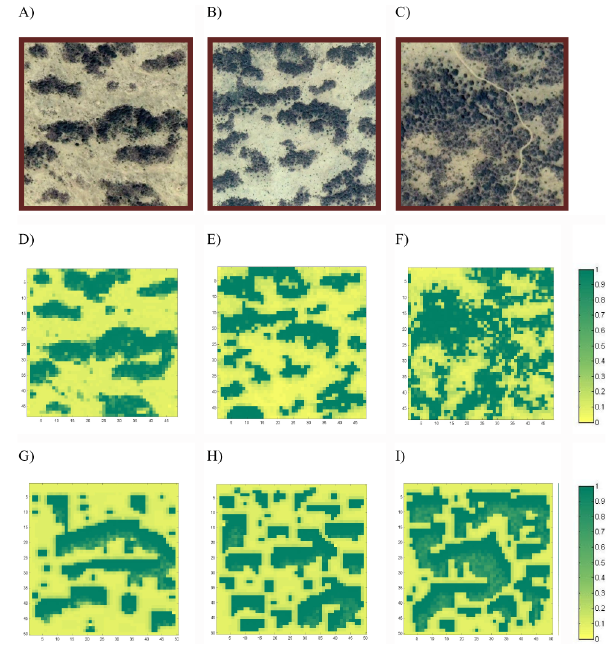
Fig. 3. Qualitative schematization of the interactions between soil, climate and vegetation. (A) Effect of vegetation on soil permeabil- ity. (B) Effect of vegetation on run-on infiltration. (C) Effect of soil moisture on soil reflectance. (D) Effect of roots on soil moisture. (E) Other spatial interactions (effect of vegetation on wind, light, nutrients, etc.).